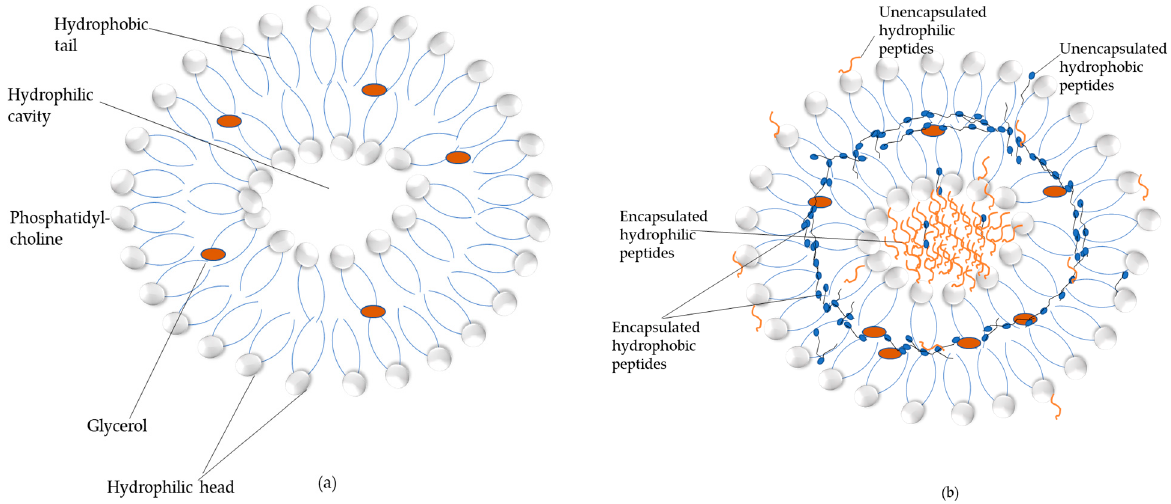
Figure 4. Schematic diagram representing the arrangement of lipids and proteins in an ( a ) empty liposome and ( b ) encapsulated liposome.